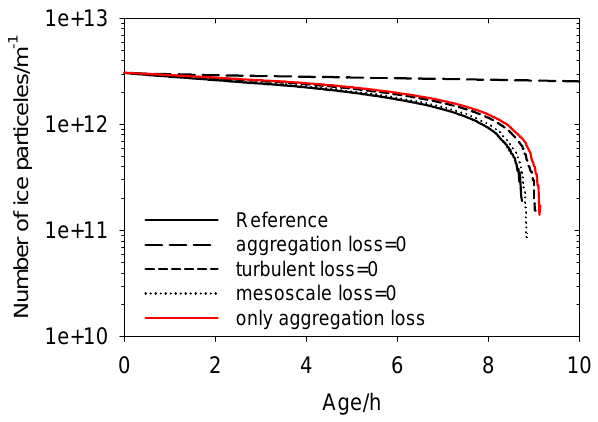
Fig. 16. Ice number per distance: Impact of omitting certain particle loss